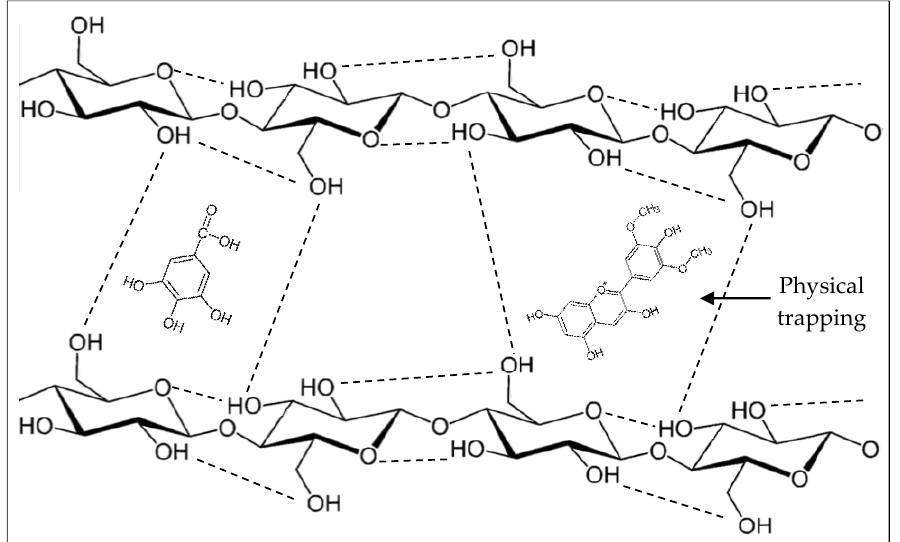
Figure 1. Physical trapping of phenolic compounds in cellulose fibers.